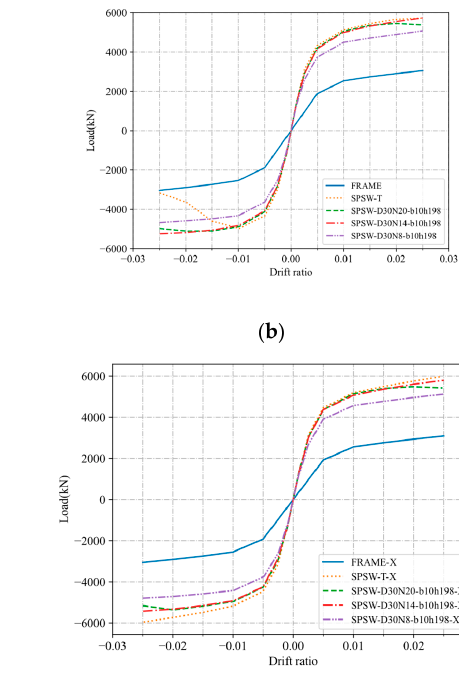
Figure 12. Comparison between hysteretic curves and pushover curves of SPSWs with di ff erent numbers of bolts, SPSWs with two-side fi xed connections and frames: ( a ) SPSW-N8; ( b ) SPSW-N14; ( c ) SPSW-N20; ( d ) SPSW-N8-X; ( e ) SPSW-N14-X; ( f ) SPSW-N20-X; ( g ) SPSW-T; ( h ) SPSW-T-X; ( i ) FRAME; ( j ) FRAME-X.